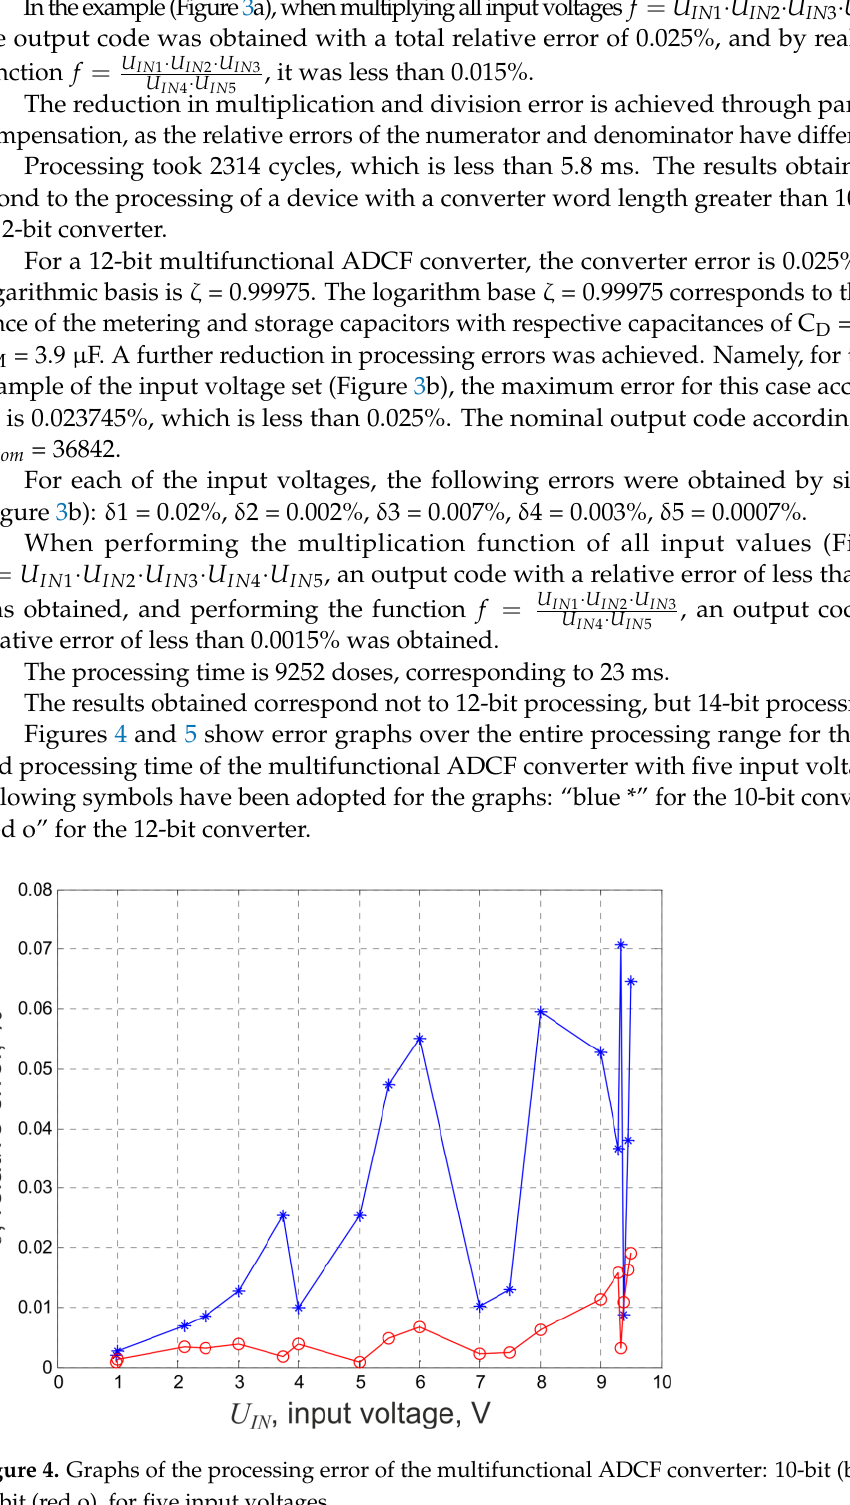
Figure 5. Graphs of processing time of the multifunctional ADCF: 10-bit (blue *) and 12-bit (red o), for five input voltages. Figure 6 shows graphs of the total voltage errors in the Figure 6a,b parts of the input voltage range for a ten-input multifunctional ADCF. Figure 7 shows graphs of the dura- tion of voltage processing in the Figure 7a,b parts of the input voltage range for a ten- input multifunctional ADCF. The chart s use the following designation: “blue x” for the 10- bit converter, and “red o” for the 12 -bit converter.